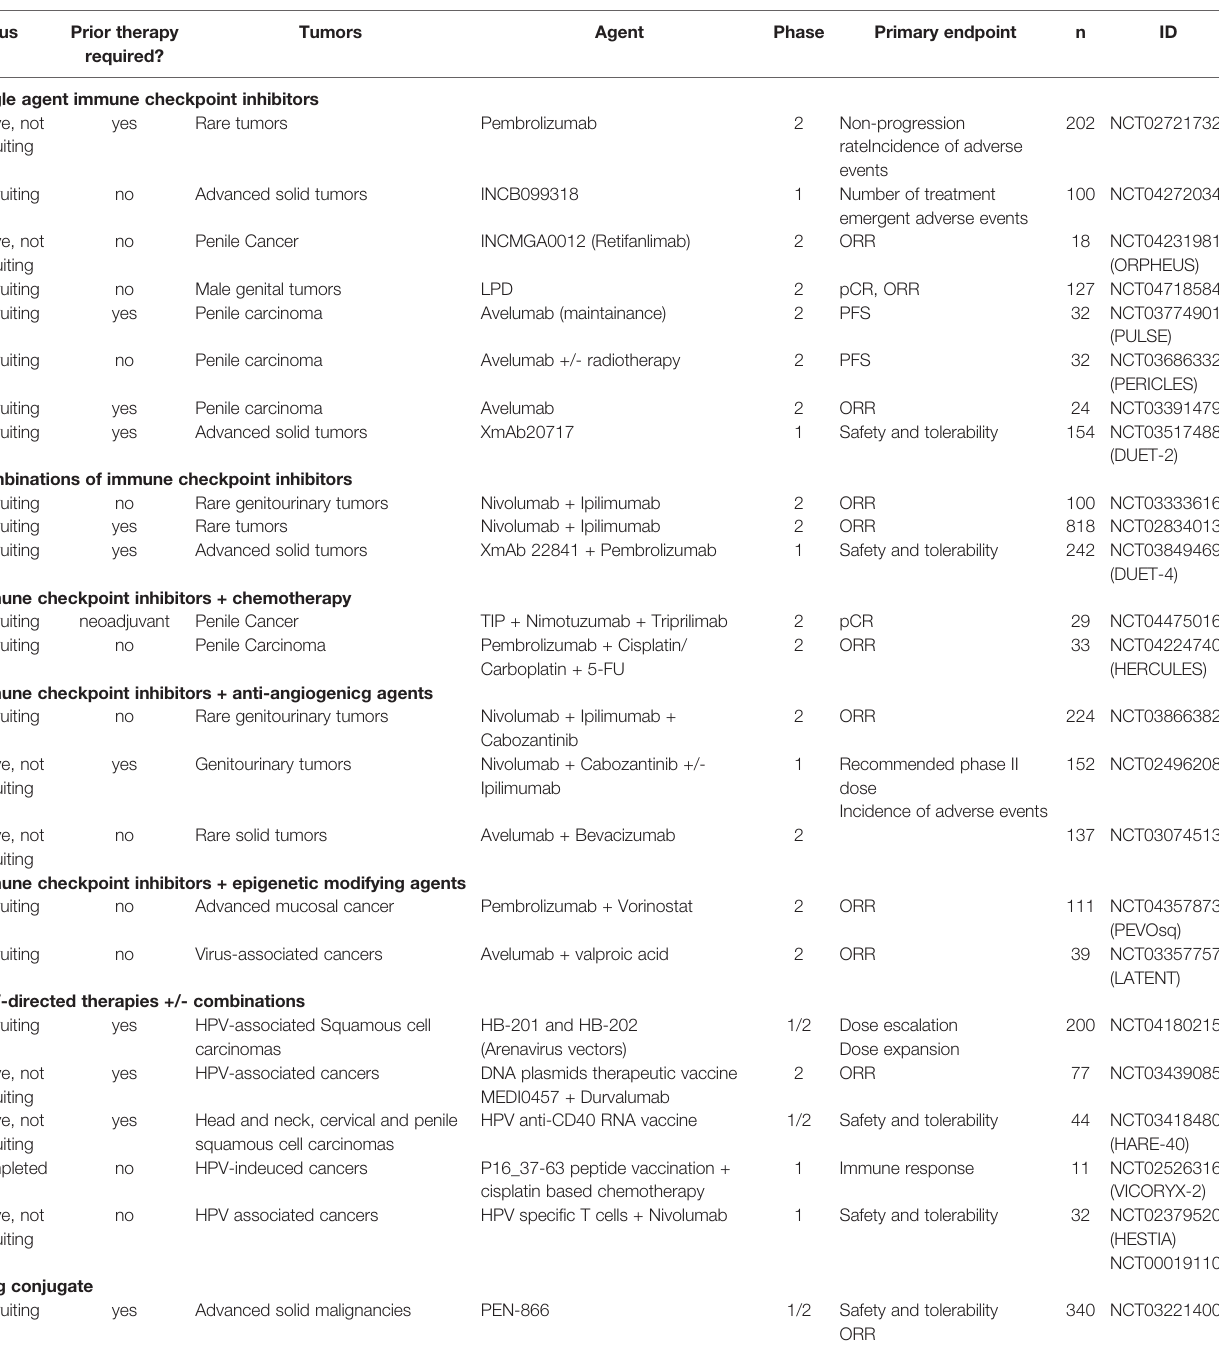
TABLE 1 | Ongoing clinical trials in advanced penile